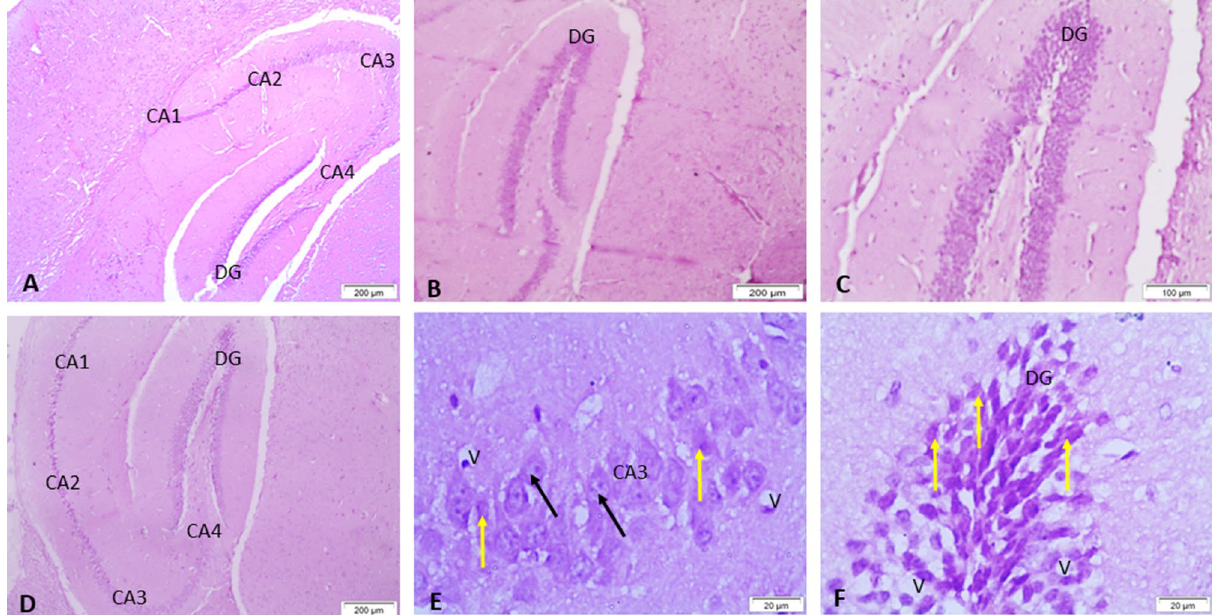
Figure 4. Representative micrograph of the blank nanoemulsion group showing normal the hippocampal region in the form of CA1, CA2, CA3 & CA4 regions and dentate gyrus (DG) ( A ); Normal hippocampal region in gum Arabic loaded nanoemulsion group ( B , C ). ( B – L ); bromobenzene + gum Arabic loaded nanoemulsion group showing some pathological changes in the hippocampal region in CA3 region including neurons with prominent nuclei (black arrows), apoptosis (yellow arrows), neuronal necrosis (white arrows), DG region shows vacuolation (V) and apoptosis (yellow arrows) ( D – F ). HE.